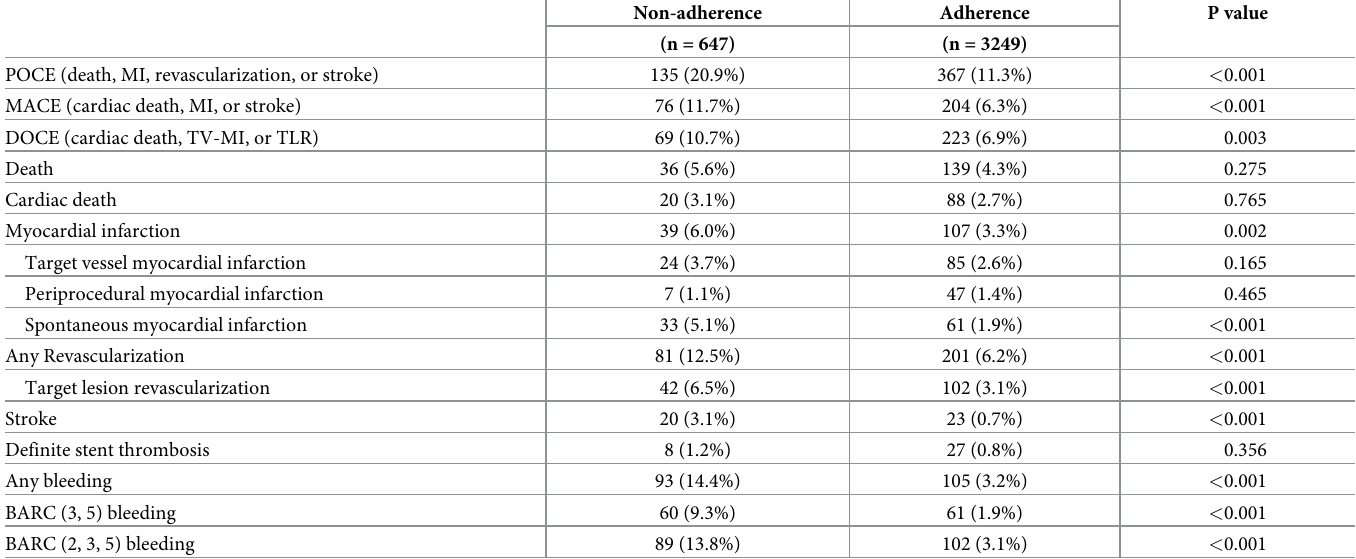
Table 2. Event rate at 1 year.